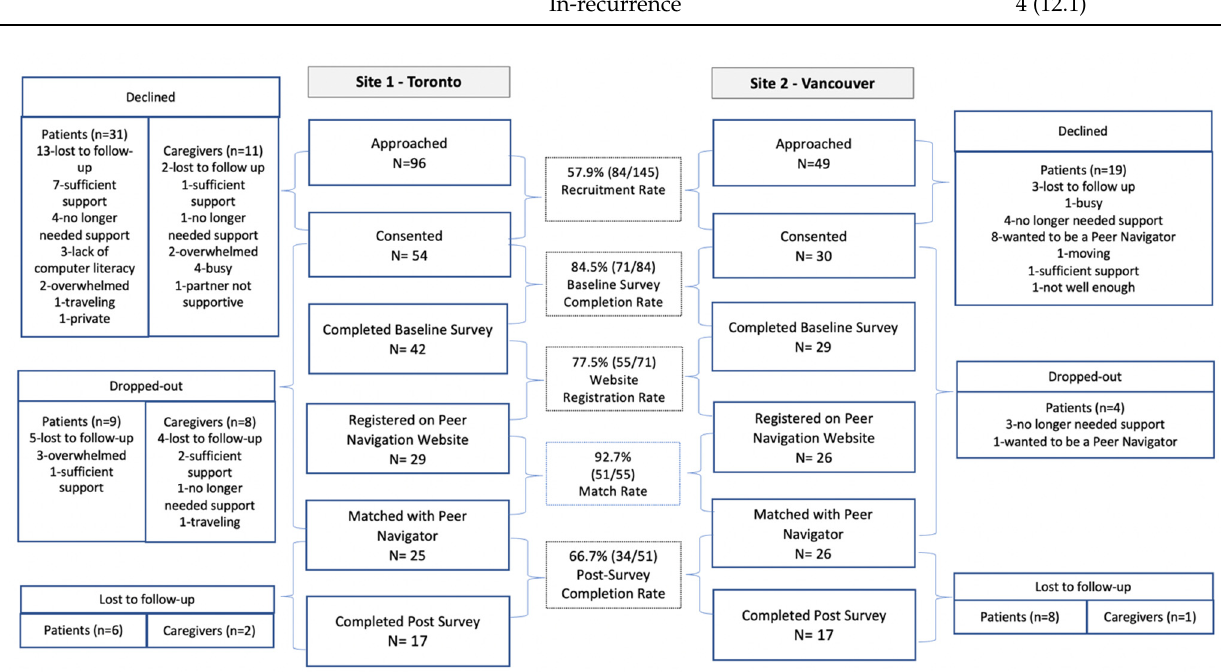
Figure 1. Participant flow diagram. Table 1. Participant characteristics.